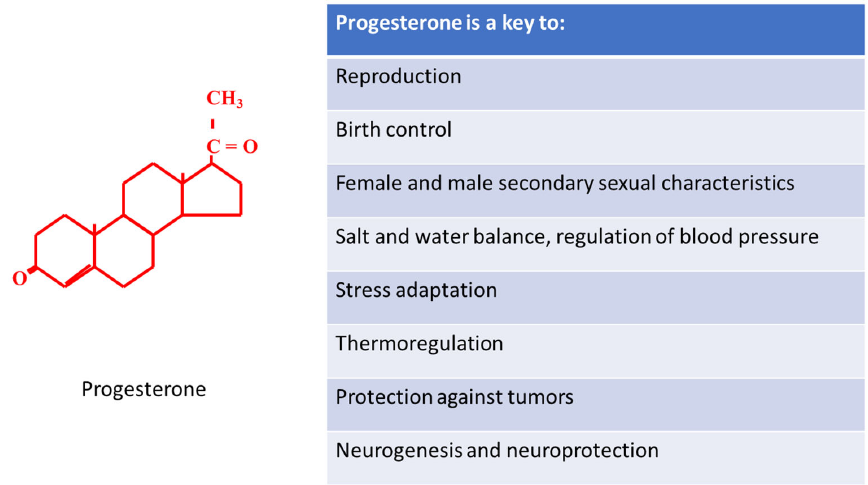
Figure 4. Is progesterone really a key to life? Although several studies prove the importance of progesterone in various essential physiological processes, we are far from completely understanding the key role of progesterone in the miracle of life.